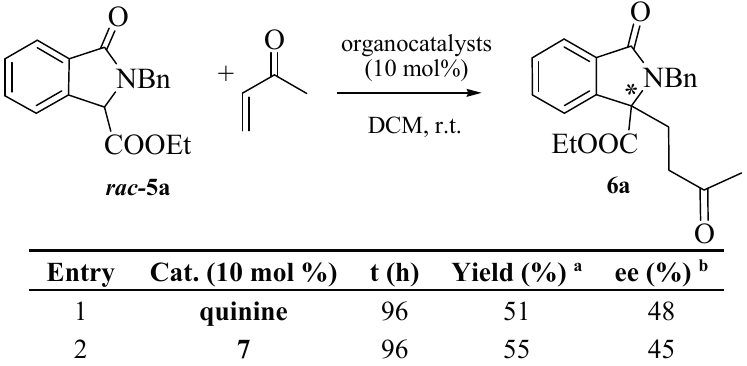
Table 1. Chinchona based organocatalysts in the and identified Michael reaction of 3-substituted